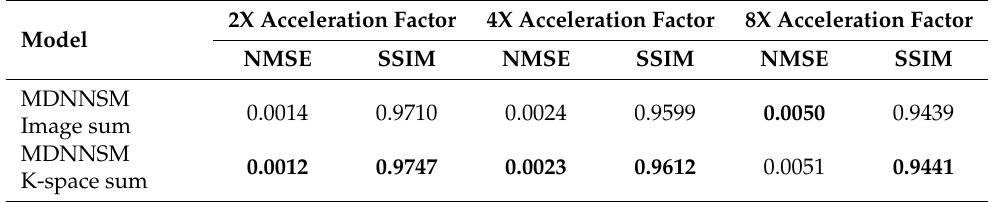
Table 3. Quantitative evaluation of reconstructed T1-weighted images depending on the accumulat- ing domain.